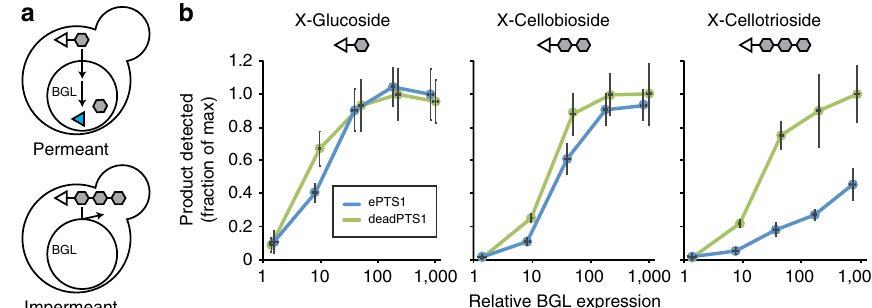
Figure 5 | Oligosaccharide-based assay reveals size-dependent permeability of the peroxisomal membrane. ( a ) Yeast cells expressing a peroxisomally localized b -glucosidase (BGL) were fed 5-bromo-4-chloro-indoxyl (X) dye molecules (triangles) conjugated to glucose chains of increasing length (hexagons). BGL can cleave the dye-sugar conjugates, releasing the fluorescent dye molecule (blue triangle), but only if those conjugates are able to cross the peroxisomal membrane to access the BGL. Impermeant substrates should be unable to access the BGL and thus should generate no fluorescence. ( b ) Relative fluorescent product release in yeast strains expressing increasing amounts of peroxisomal (blue lines) or cytosolic (green lines) BGL. Dye–sugar reactions involving X-glucoside ( M w ¼ 408.63Da), X-cellobioside ( M w ¼ 570.78Da) and X-cellotrioside ( M w ¼ 732.93Da) are described in detail in Supplementary Fig. 9. Error bars are the mean ± s.d. of six biological replicates.